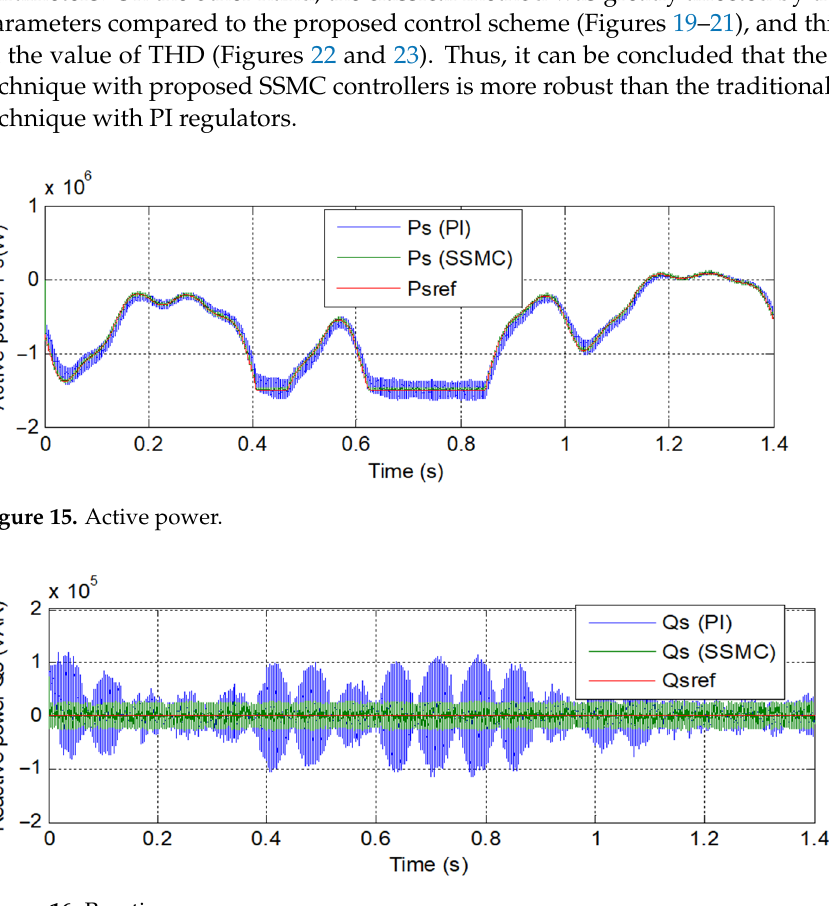
Figure 16. Reactive power.